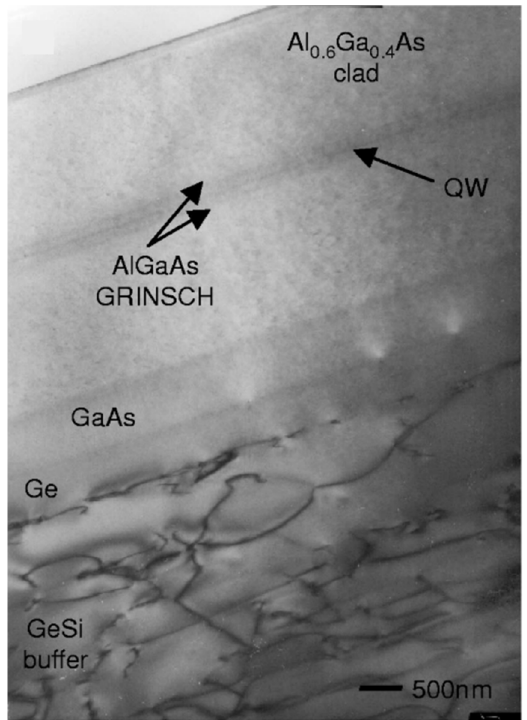
Figure 11. Cross-sectional TEM image of GaAs-based laser structures on germanium (Ge)/GeSi/Si. Reprinted with permission from Reference [158] © 2003 American Institute of Physics.